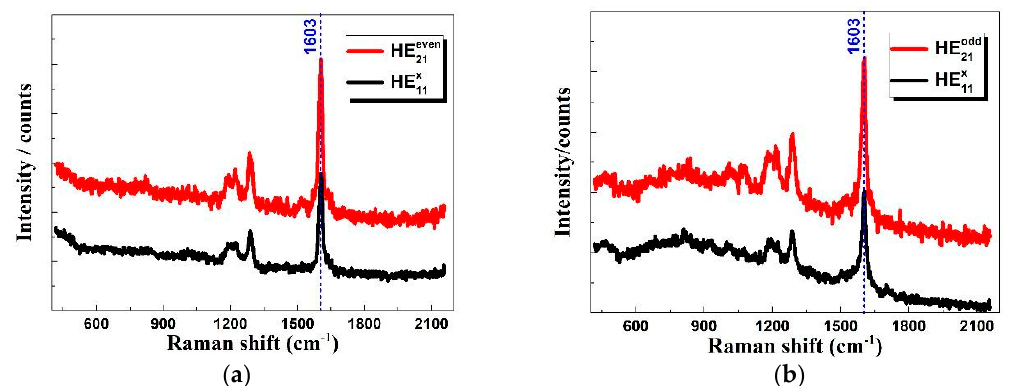
Figure 4. Tip-enhanced Raman spectra of 4-PBT with different excitation beams, ( a )